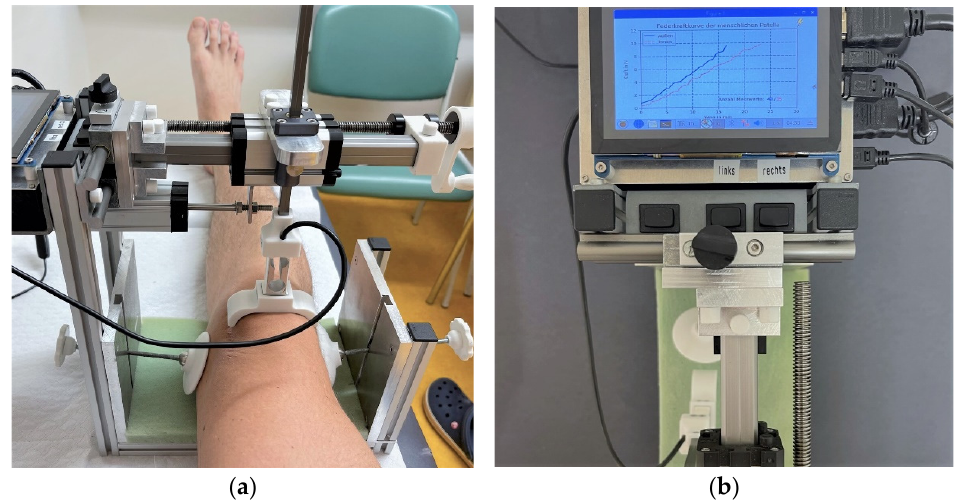
Figure 2. Measurement with the Patellostabilometer: ( a ) right leg correctly positioned in the device with the grip in the neutral position; ( b ) view from above at the LCD-screen, showing the acquired diagram of mediolateral mobility after a successful measurement. Red line represents the medial displacement, blue line the lateral one.